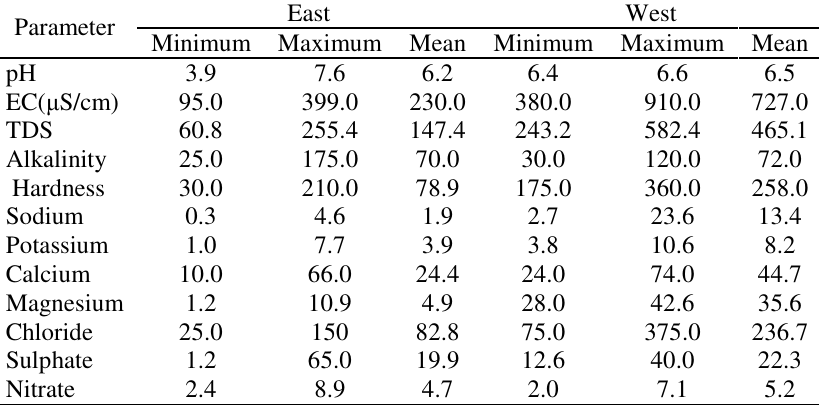
Table 2. The physicochemical parameters of groundwater samples of Eloor (Eastern and Western) in ppm.